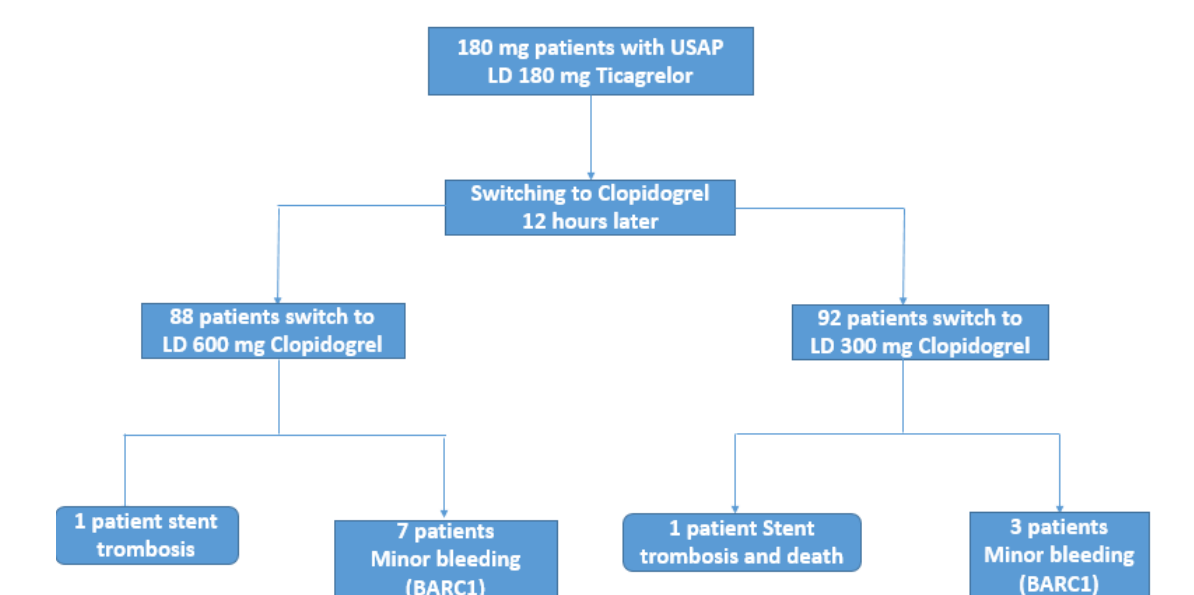
Figure 2. Diagram depicting the patient pathway and outcomes for switching from Ticagrelor to Clopidogrel with either 300 mg or 600 mg loading dose during a one-month follow-up.